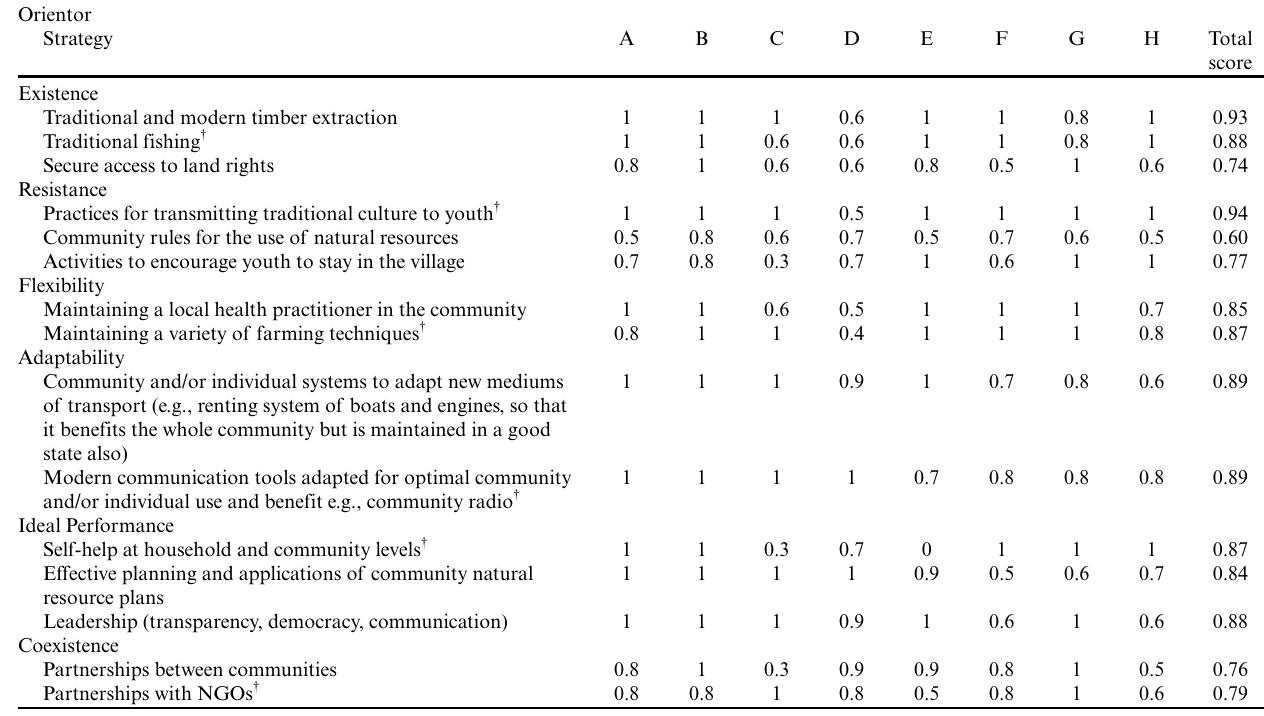
Table 1 . Summary of the Multicriteria Analysis (MCA) analysis, with the short-listed best practices agreed with the communities to be investigated in more detail shown with a dagger (†). Column headings and weightings: A = Does the strategy have a satisfactory status? (1); B = Was the indicator well thought through? (0.6); C = How many other communities are using this strategy? (0.5); D = Does the strategy contribute to make the best case scenarios happen? (1); E = Is the strategy community owned? (1); F = Is the strategy easy to capture through video and photos? (1); G = Are there people who can represent and execute the strategy well? (1); H = How transferable is the strategy? (1).